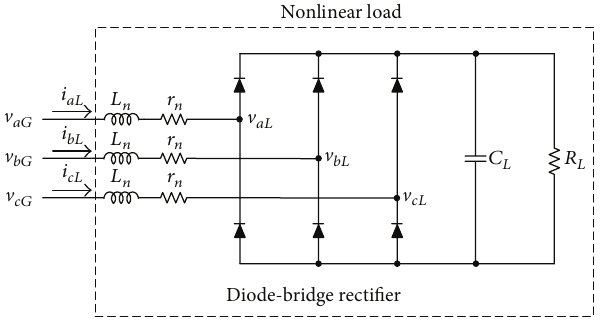
Figure 6: Power circuit of nonlinear load in the proposed